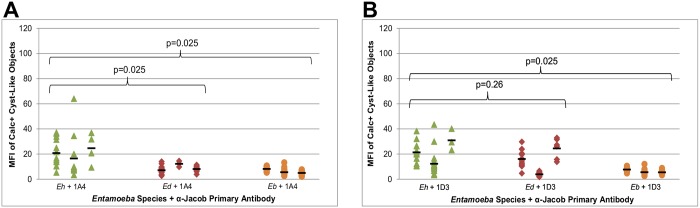
Entamoeba species specificities of a-Jacob antibodies 1A4 (A) and 1D3 (B) in immunofluorescence microscopy.Smears of xenic Entamoeba isolates were doubly stained with 0.1% Calcofluor White M2R and an anti-Jacob primary antibody with goat anti-mouse Alexa-Fluor 488. Each data point represents the mean Alexa Fluor 488 intensity of a Calcofluor-positive, cyst-like object detected by microscopy. The data points are arranged horizontally by isolate, and black horizontal bars represent the mean Alexa Fluor 488 intensity of each isolate. The overall mean Alexa Fluor 488 intensities of the Entamoeba histolytica isolates (n = 3) were compared to those of E. dispar isolates (n = 3) and of Entamoeba bangladeshi isolates (n = 3) with the Mann-Whitney U test. Eh = Entamoeba histolytica, Ed = Entamoeba dispar, Eb = Entamoeba bangladeshi.